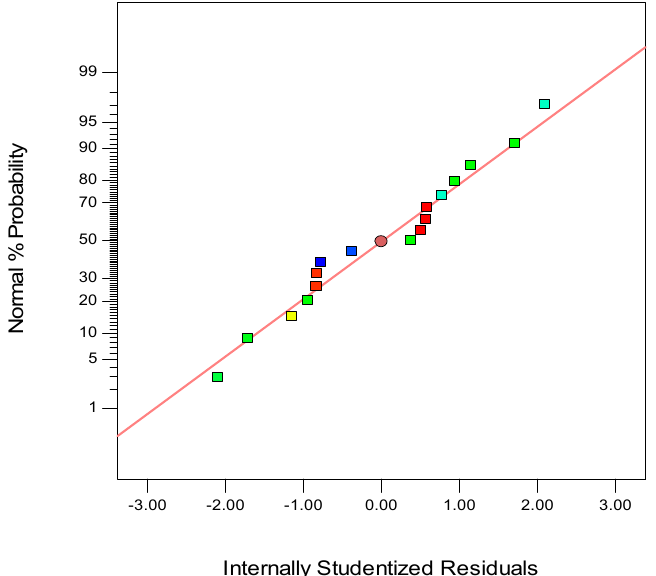
Figure 7. Normal percentage probability plot .